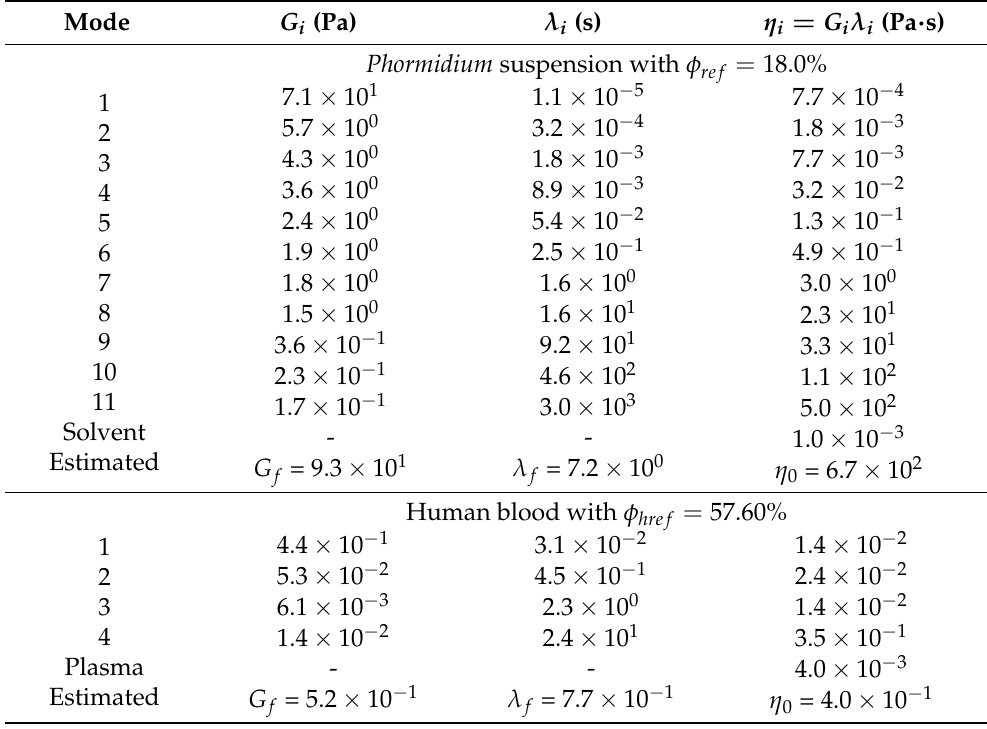
Table 1. The typical relaxation spectrum of the master curve of Phormidium suspension with φ ref = 18.0% and human blood with φ href = 57.60% fitted by using IRIS Rheo-hub software [27]. The mean characteristic time λ f , the mean modulus G f and the zero-shear viscosity η 0 are also estimated and